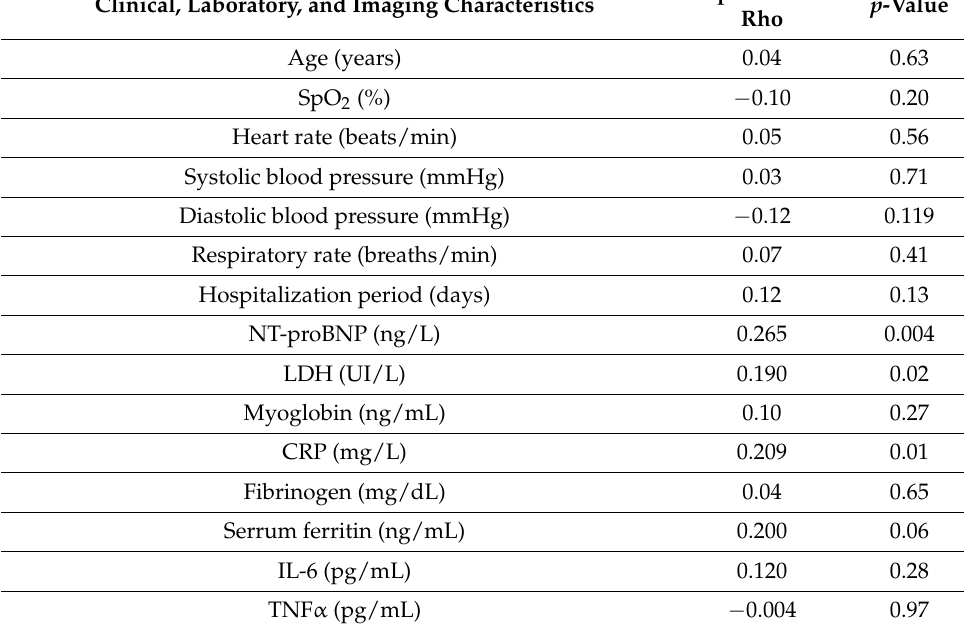
Table 4. Correlations of clinical, laboratory, and imaging parameters with myocardial